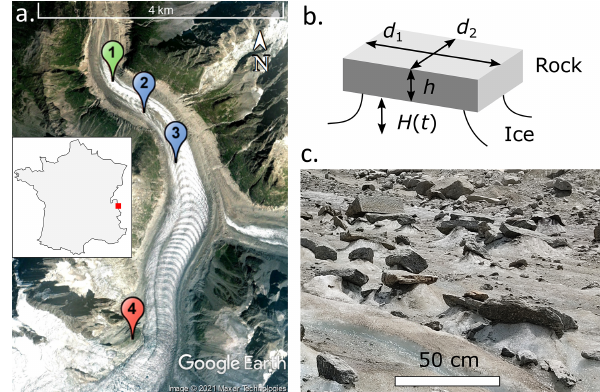
Figure 2. (a) Map of the Mer de Glace in the French Alps (Google Earth image © 2021 Maxar Technologies) locating the measure- ment site of 3 June 2021 (1), the time-lapse observation sites of June 2021 (2) and June 2019 (3), and the Requin AWS (4). (b) The 3D schematics of a typical glacier table defining the height H(t) of the ice foot and the average thickness h and widths d 1 and d 2 of the rock. (c) Picture of a portion of the glacier taken in June 2021 showing natural glacier tables, from which the data shown in Fig. 3 were